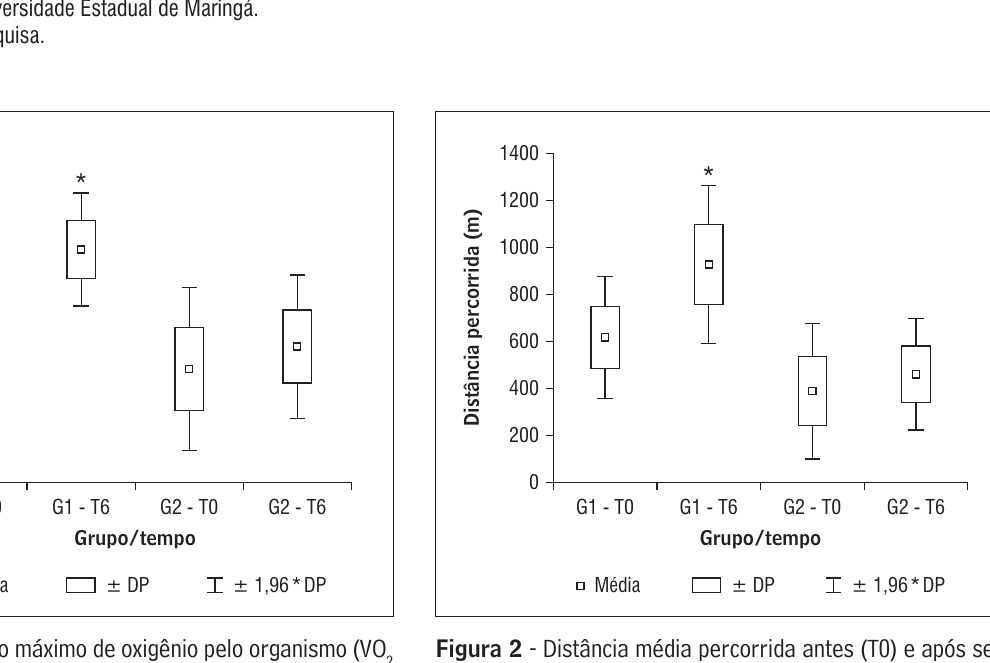
Figura 2 - Distância média percorrida antes (T0) e após seis 2 semanas (T6) em mulheres entre 40 e 60 anos e da Classe I da New York Heart Association, com sorologia positiva para Trypanosoma cruzi, no gru- po G1 (com exercício físico aeróbio) e no G2 (sem